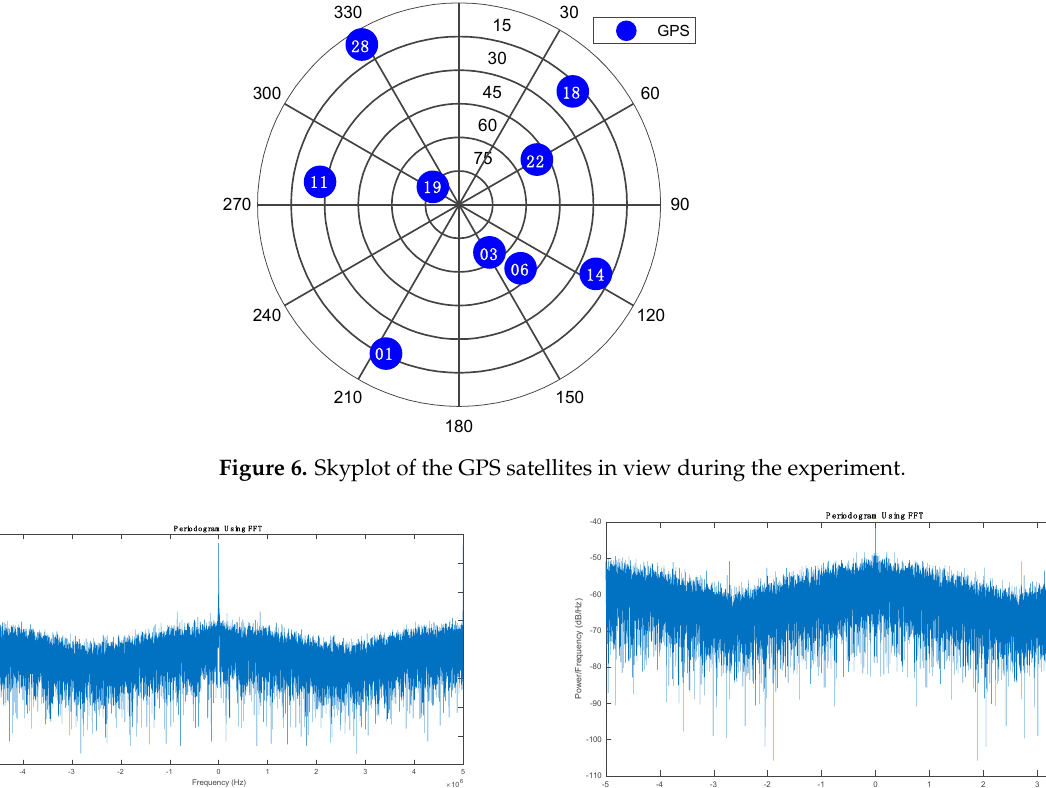
Sensors 2021 , 21 , x FOR PEER REVIEW